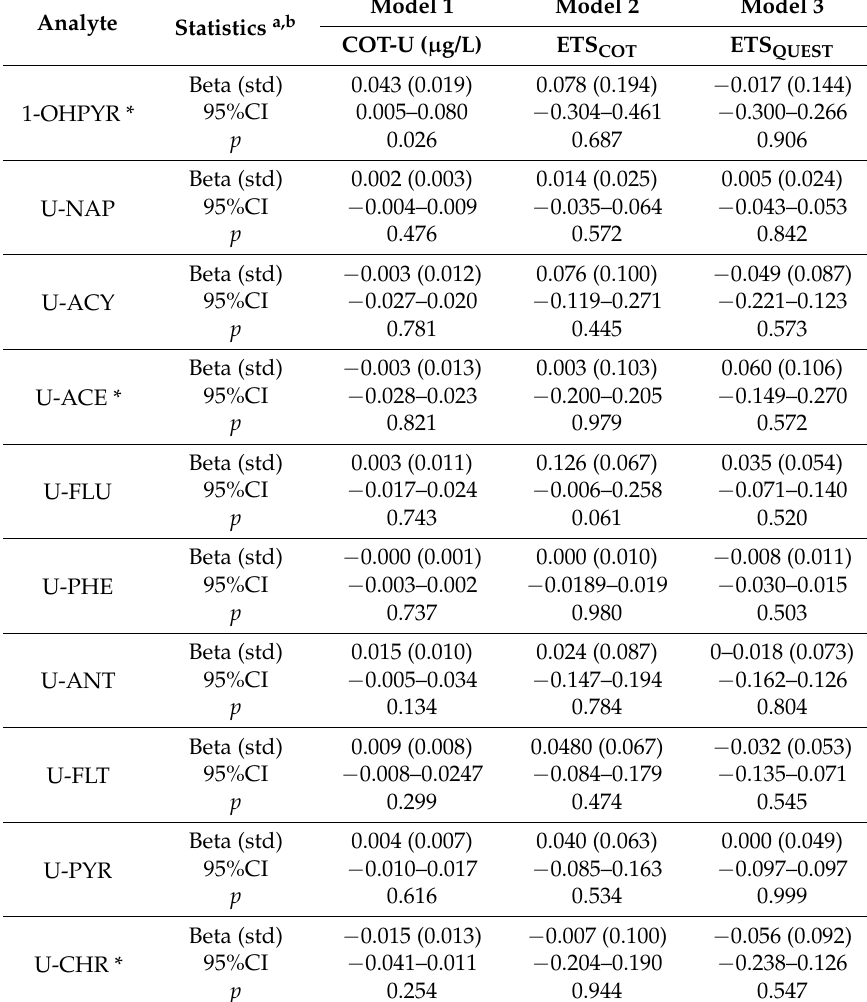
Table 3. Results of multiple linear regression analyses for predicting the levels of urinary PAHs and 1-OHPYR in study subjects. ETS exposure was introduced in the regression models alternatively as a continuous variable (unadjusted COT-U levels, Model 1), or as a dichotomous variable (ETS COT in Model 2, and ETS QUEST in Model 3). Beta-coefficients ( β ) of ETS exposure, together with the 95% confidence intervals, are shown regardless of the significance level. The complete regression model is shown in Supplementary Table S1 for Model